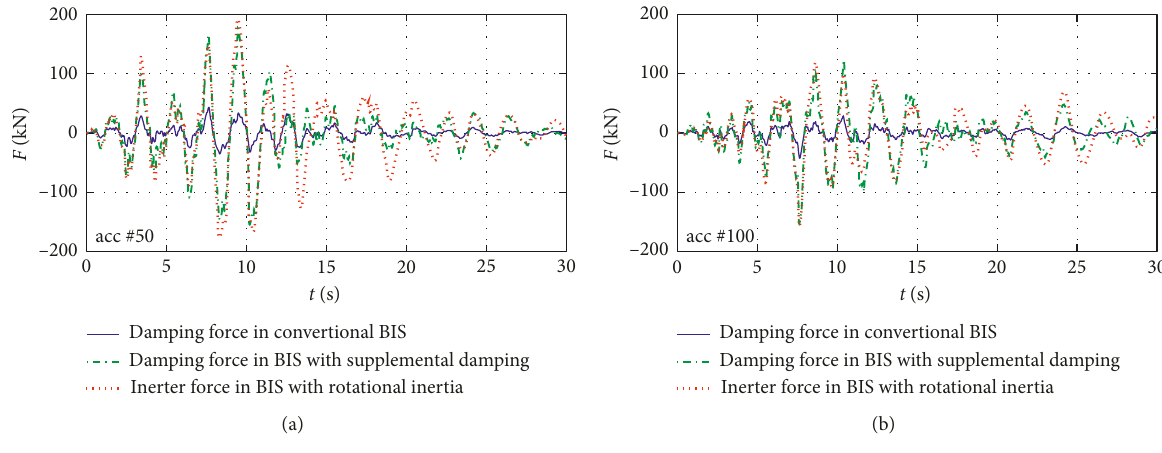
Figure 16: Time-history for reactive forces relevant to two arbitrary artificial accelerograms.